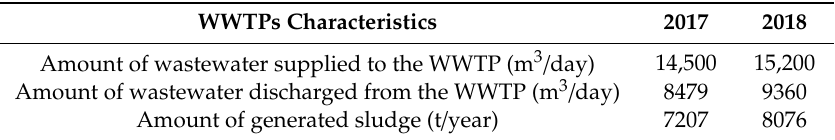
Table 1. Information about the amount of processed wastewater and sludge during the investigation